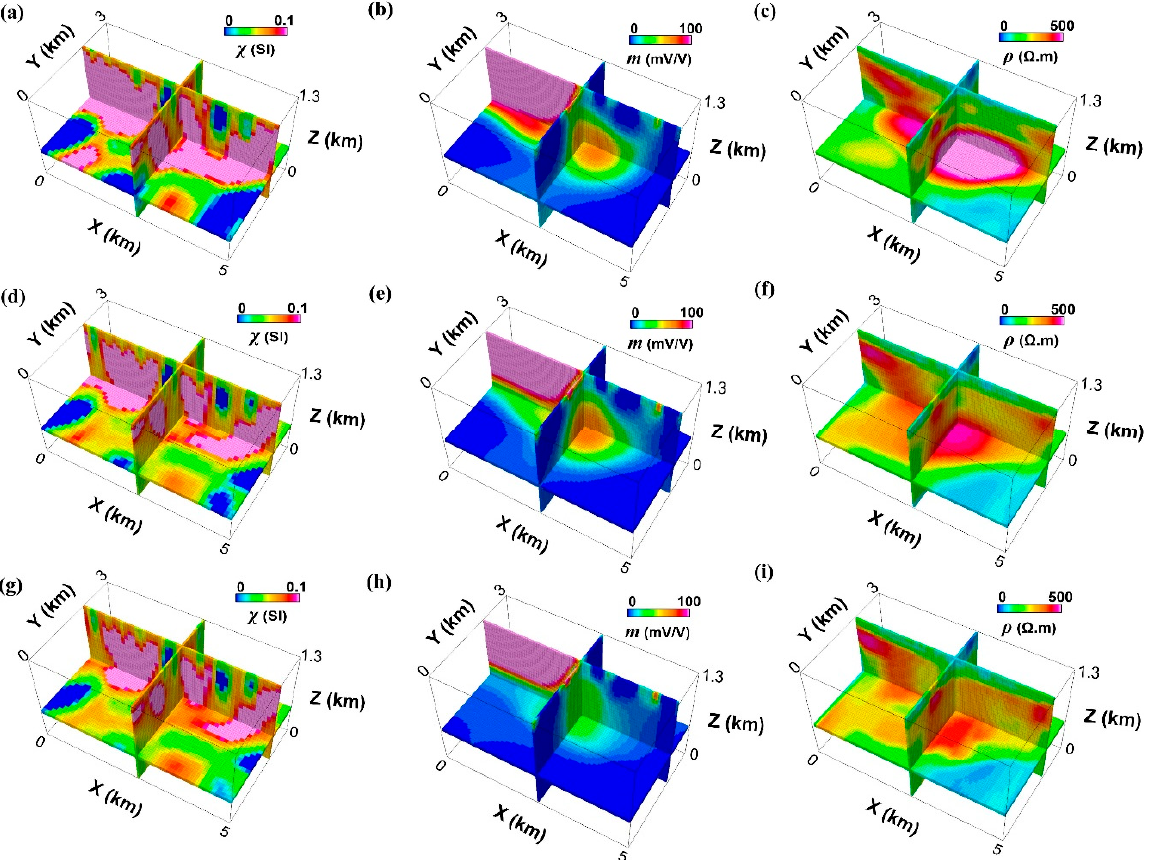
Figure 9. Geophysical inversion results: ( a – c ) smooth inversion results; ( d – f ) sharper inversion results; ( g – i ) sharpest inversion results.